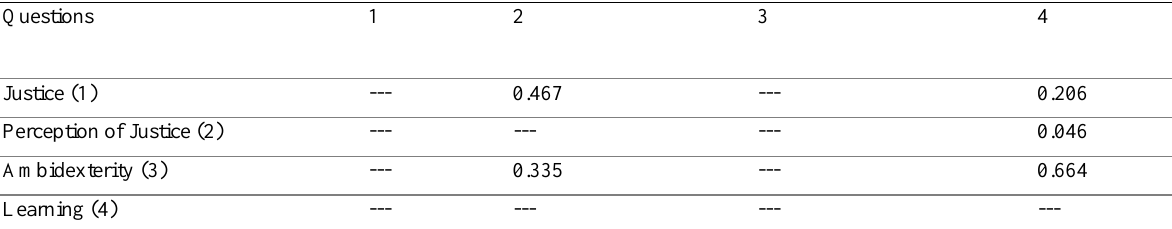
Table 7: Path Model-Beta Values